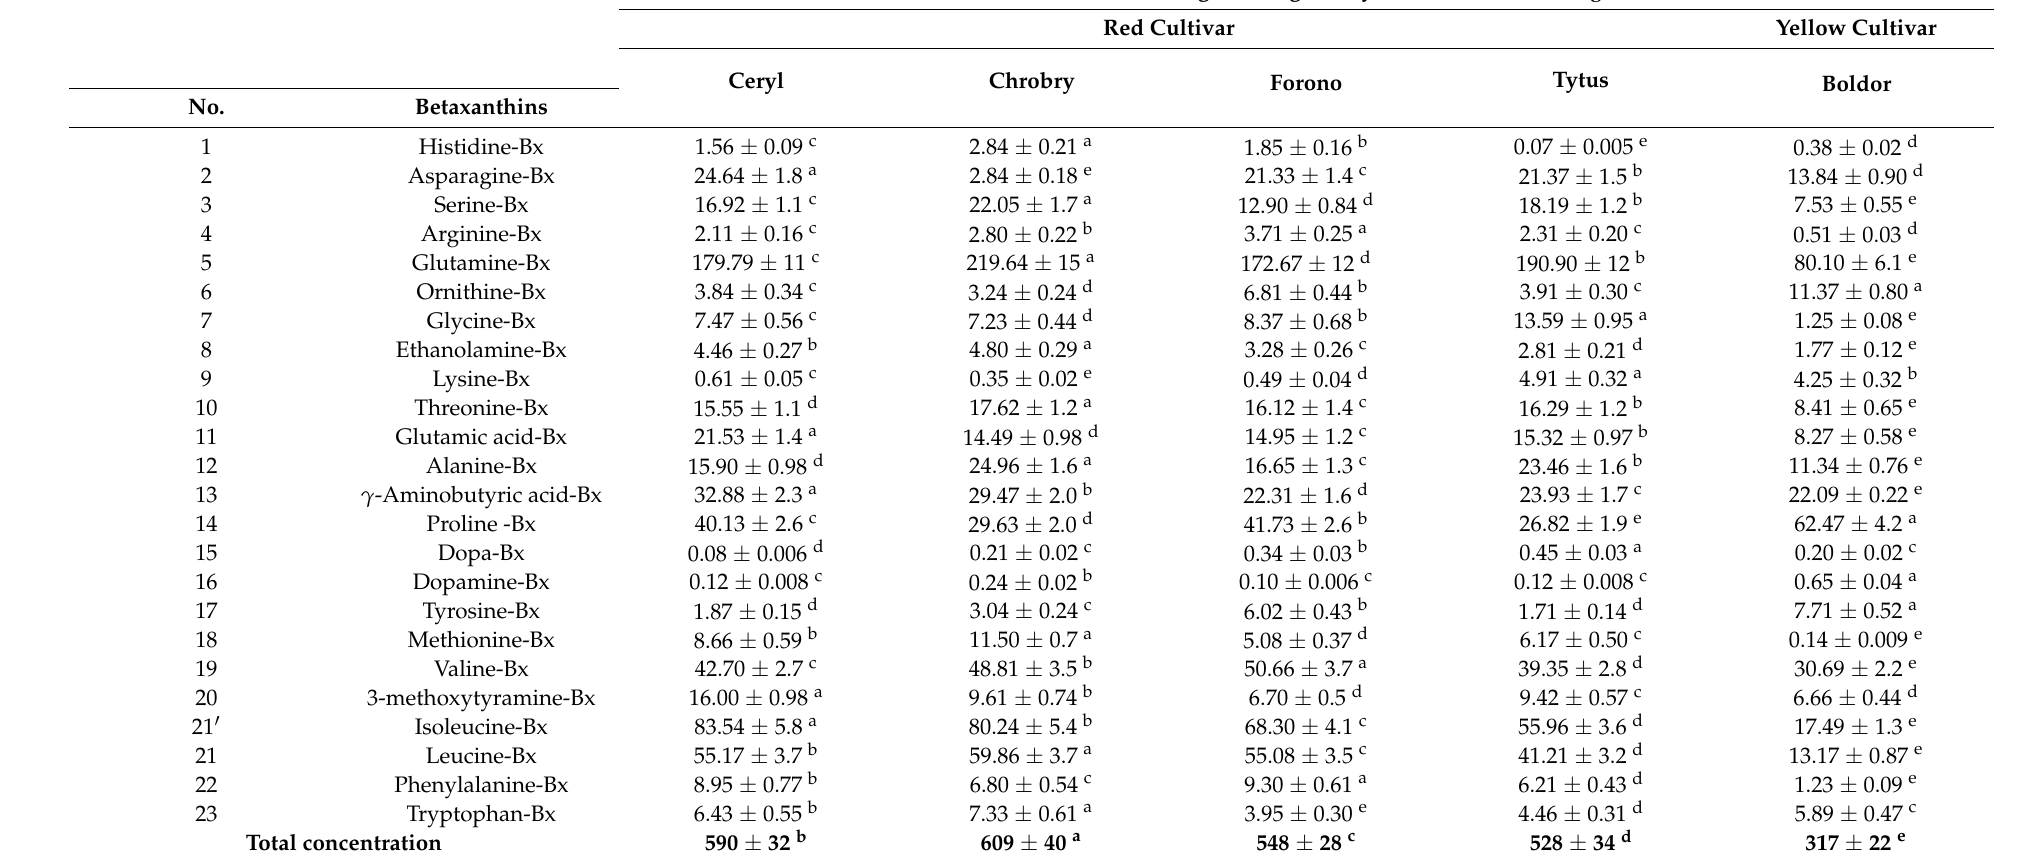
Table 3. Content of individual betaxanthins and total betaxanthins in the flesh of red and yellow Beta vulgaris L. cultivars (mg/100 g of Dry Extract) analyzed by